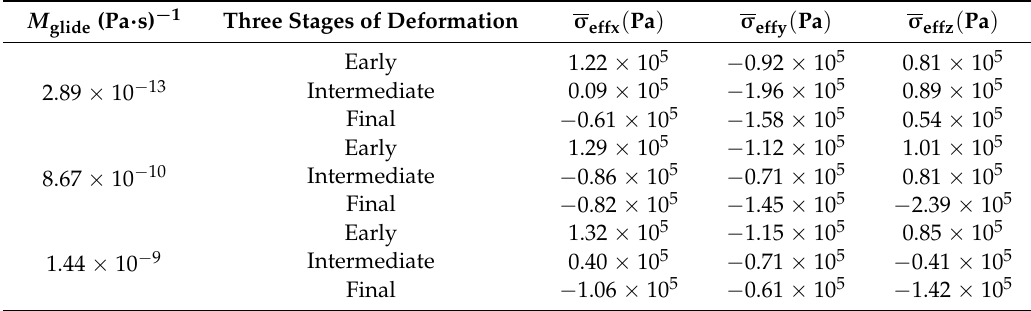
Table 1. Calculated mean value of effective stresses along x , y , and z directions at three stages of deformation.